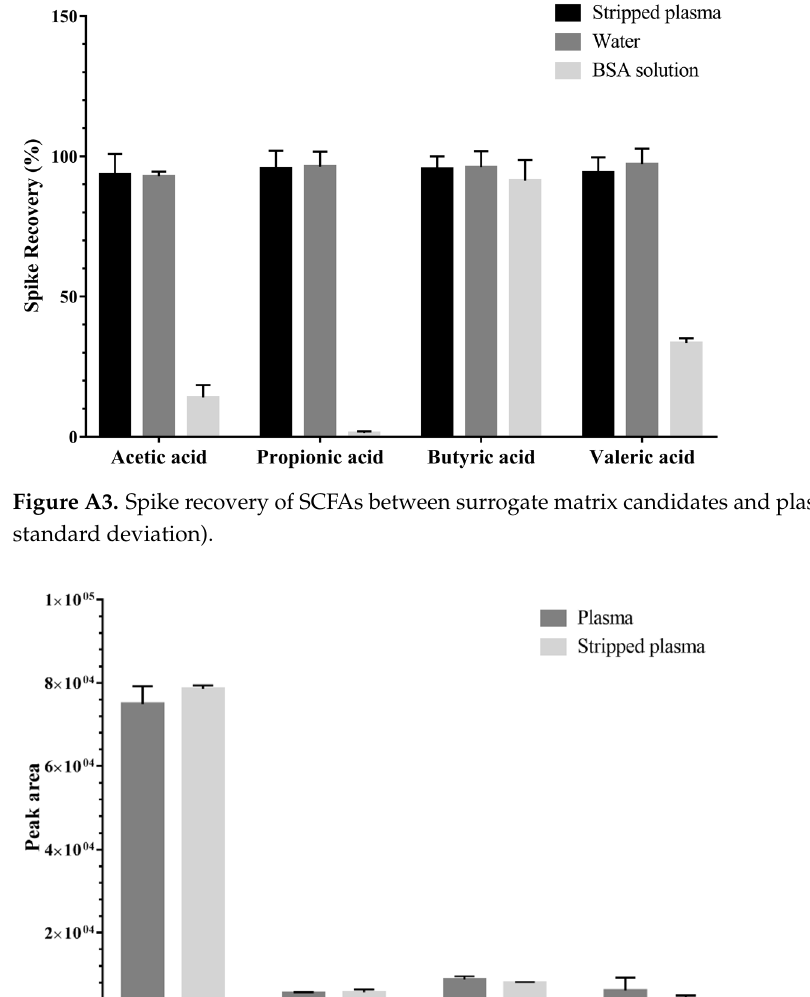
Table A2. Spiked concentration levels in each calibration range. SCFAs Spiked Concentration Levels for Calibration Ranges of Plasma and Serum (µg/mL)